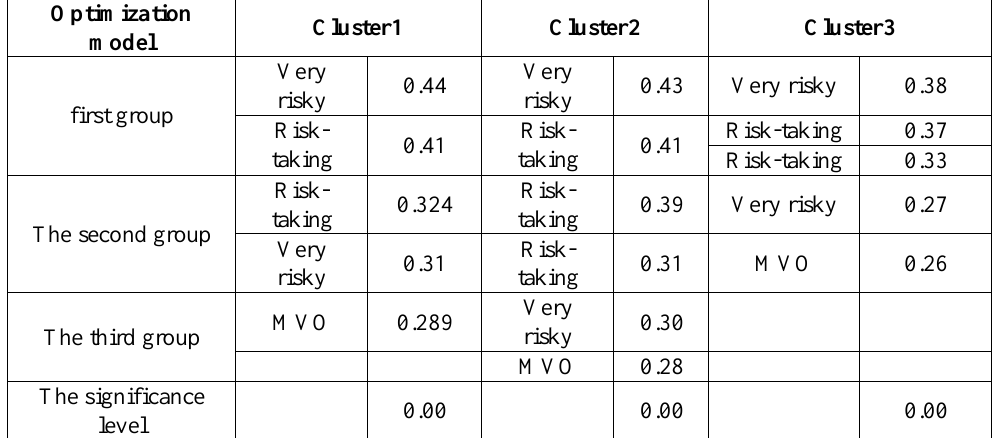
Table 6. Ranking Results by Tukey Auxiliary Test (Research Findings) Optimization